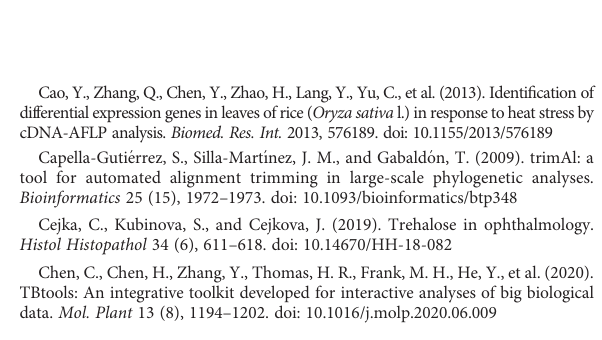
SUPPLEMENTARY FIGURE 7 Correlation test of gene expression level among samples.